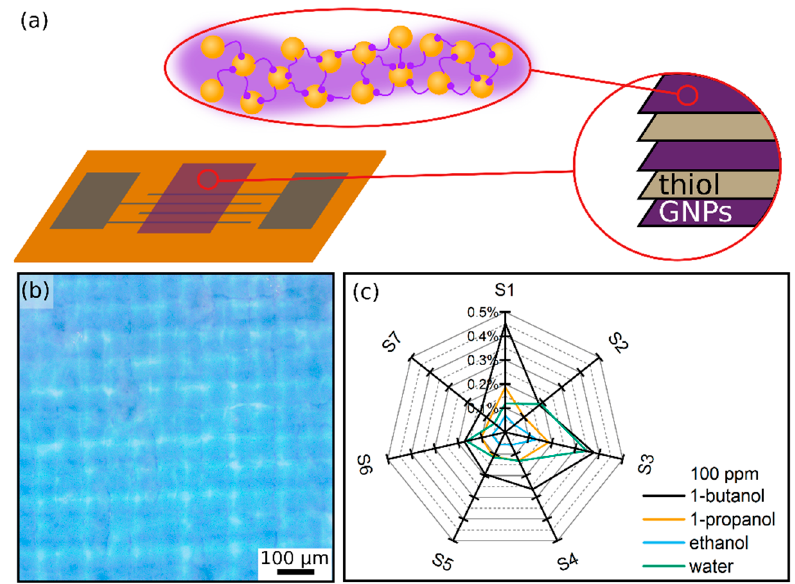
Figure 1. ( a ) Schematic zoom of a layer-by-layer inkjet-printed flexible chemiresistor on polyimide (PI) foil. ( b ) Optical micrograph of an inkjet-printed sensitive nanoparticle layer on glass. ( c ) Radar plot showing the responses of seven sensors with tuned selectivity to various